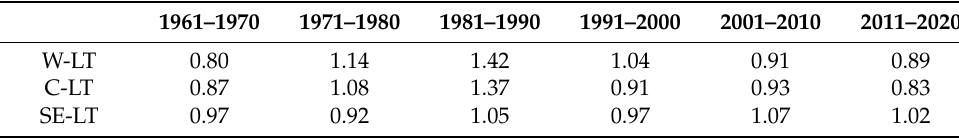
Table 3. Distribution of K by decades for hydrological